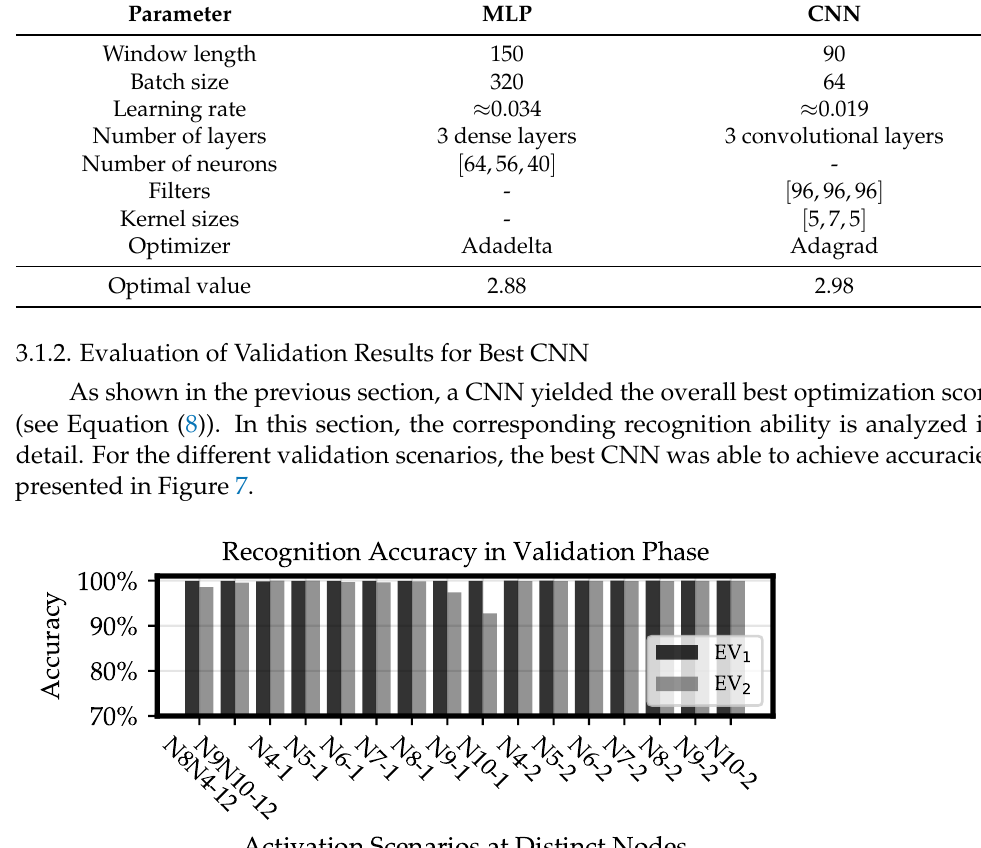
Figure 7. Recognition accuracies for different validation scenarios achieved by the best CNN found in hyper-parameter optimization. A scenario containing a single load activation of electric vehicle i at grid node Nx is named as Nx - i . A scenario containing an overlapping activation with electric vehicle i at node Nx and electric vehicle j at node Ny is named as NxNy - ij . Within these scenarios, the voltage was measured at grid node N